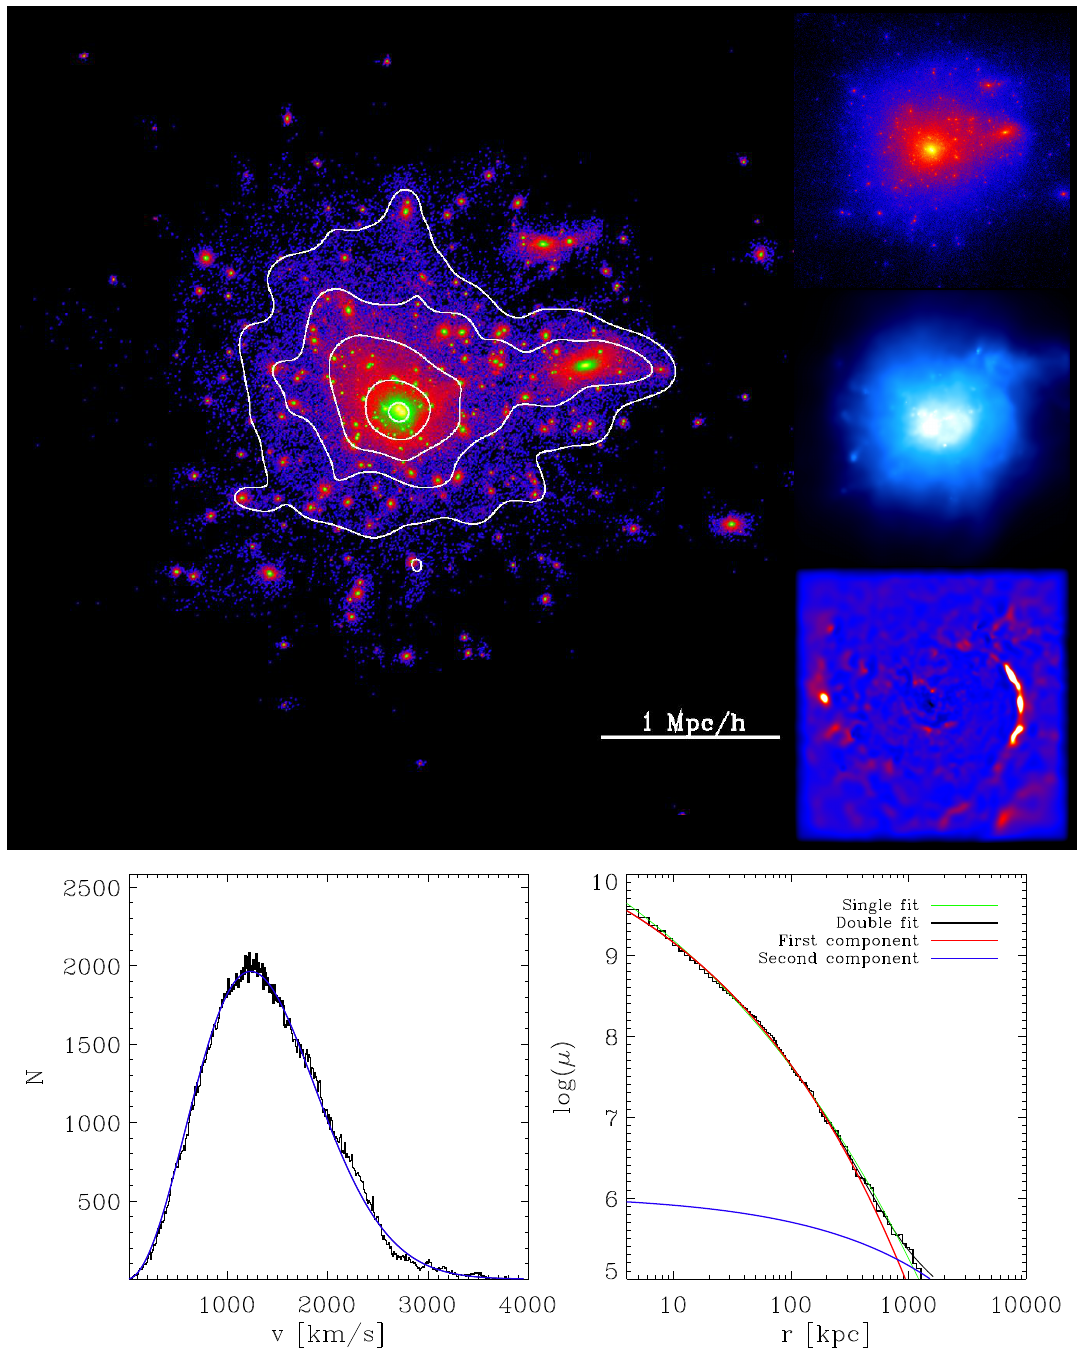
Figure 3. Same as Figure 1 but for a cluster where the velocity distribution is well described by a single Maxwellian and the radial surface density profile is also well described by a single Sérsic profile (class s/s). Although the outwards-moving substructure to the right has lost all its gas component, the injected shock within the ICM is still clearly visible as a large